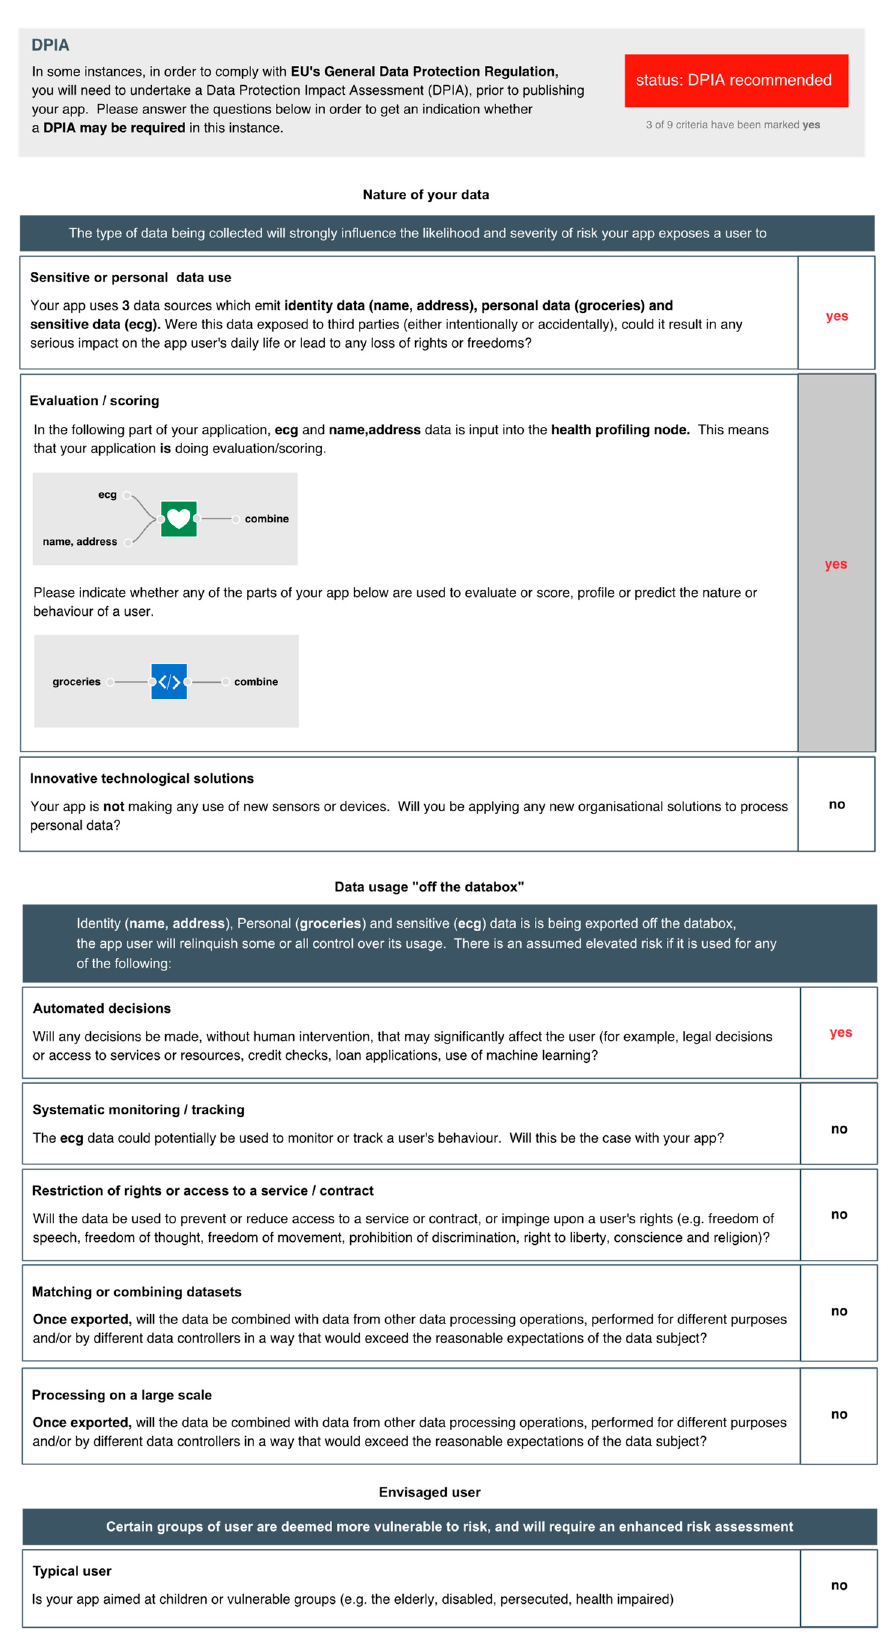
Figure 6. IDE DPIA recommendations.